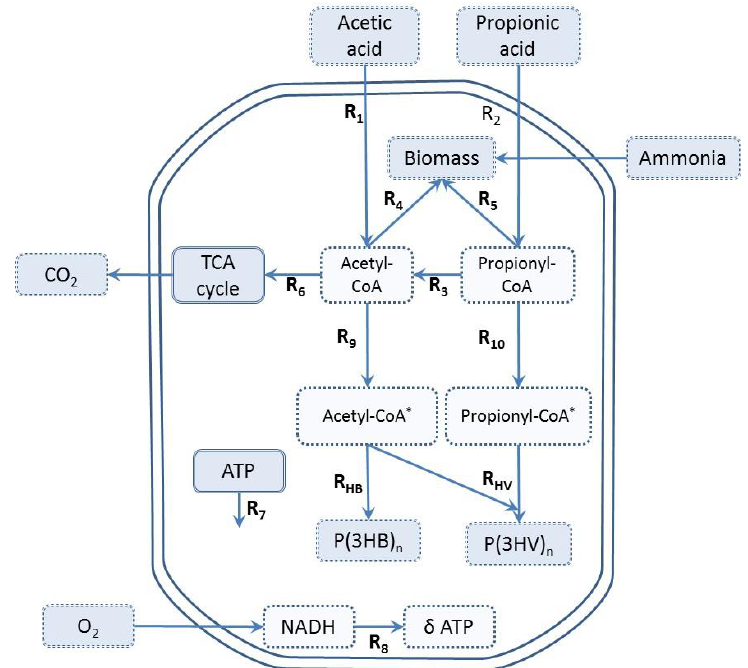
Figure 1. Metabolic network for PHBV synthesis and biomass production, adapted from [17], with permission from © 2013 Elsevier. Light blue dotted squares represent external metabolites; white dotted squares represent internal metabolites.